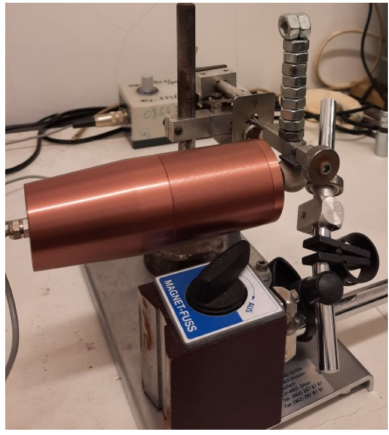
Figure 3. Ball cratering